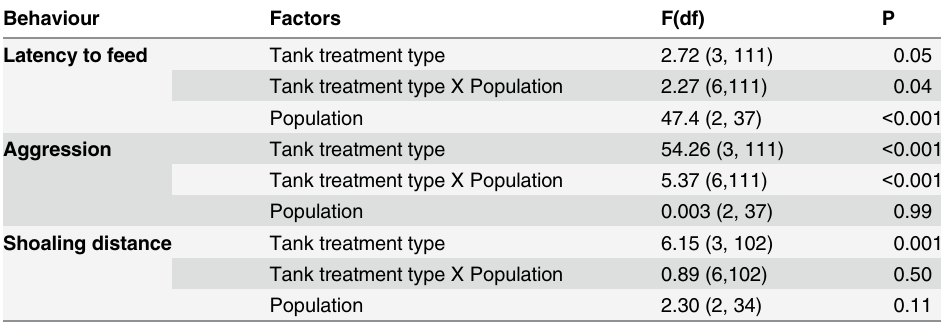
Table 1. Repeated measures ANOVA on effects of population (between subject) and tank treatment type (within subject) on behavioural